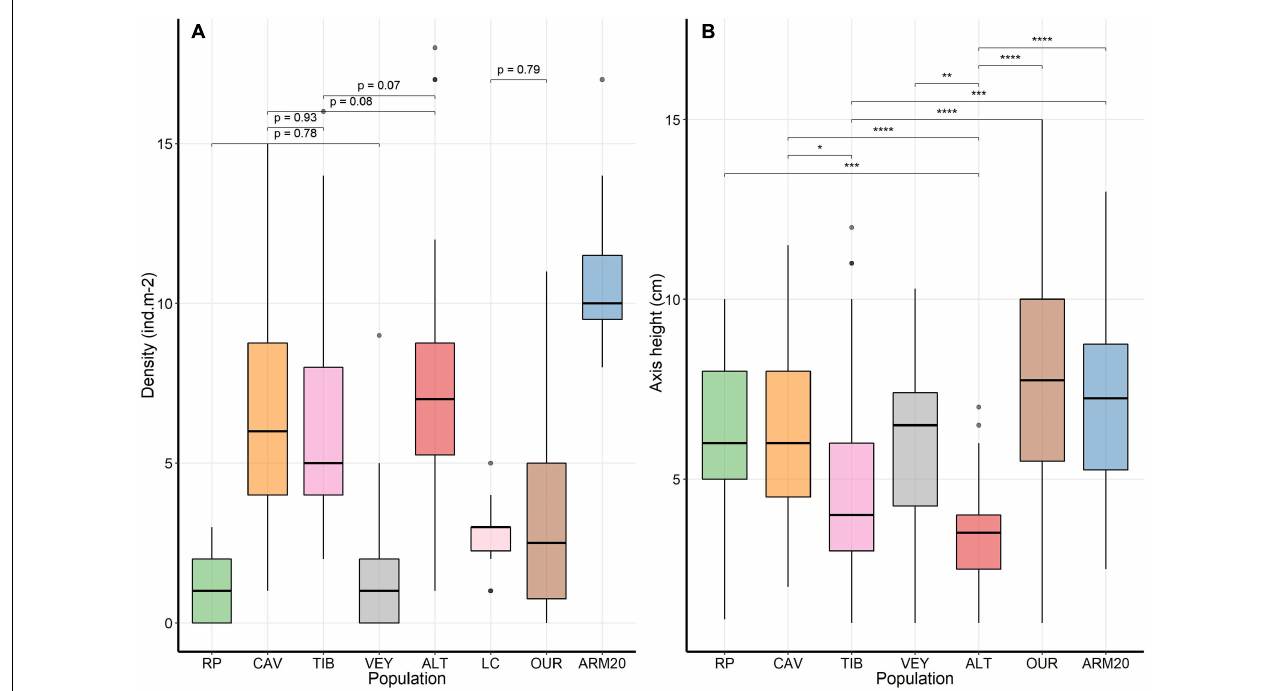
FIGURE 2 | Demographic structure of populations of Ericaria zosteroides . (A) spatial distribution of the population density (ind.m - 2 ), all pairwise comparisons are significant (pairwise Wilcoxon test, p < 0.001), except for those indicated by p > 0.05. (B) Distribution of the height of the main axis of individuals, the significant difference between populations (Tukey test, * p < 0.05, ** p < 0.01, *** p < 0.001, **** p < 0.0001) are reported.